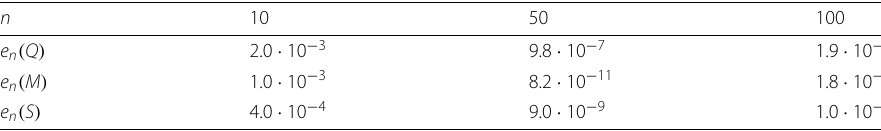
Table 3 Errors e n for g ( x ) = sin 2 π x